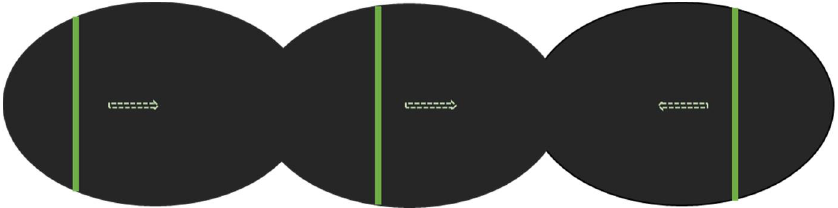
Figure 1. Schematic diagram of the subjective straight-ahead (SSA) fMRI task. Dotted arrows represent the direction of motion.